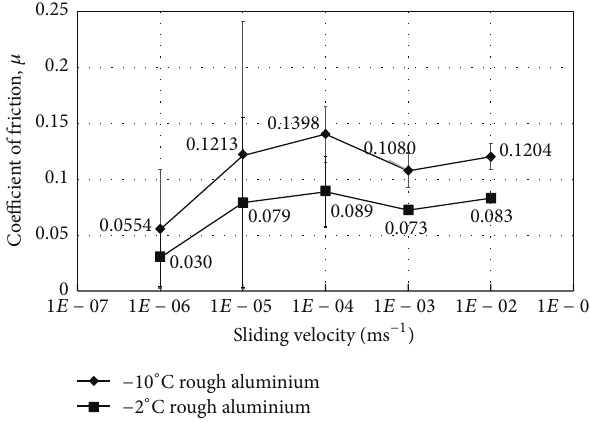
Figure 8: Friction as a function of sliding speed for ice on alu- minium,showingresultsforroughandpolishedaluminiumat − 2 ∘ C.